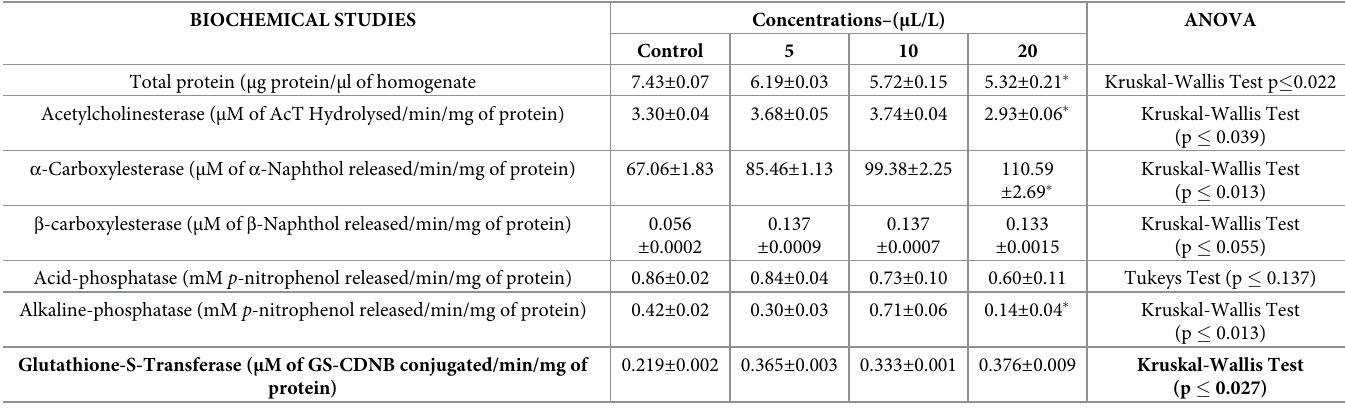
nature; they are easy to use and kill the pests of stored grains. Hence, in the present study, EO extracted from C . citrinus leaves was tested for its potential against the larvae and adult beetles of T . castaneum . GC-MS analysis of C . citrinus revealed ten different compounds, in which eucalyptol (40.44%) was the major constituent, followed by linalool, and α - Pinene. However, the same plant from Ethiopia contained 76.9% of eucalyptol and from Western Himalayas it contained only 9.8% eucalyptol [39, 40]. These data clearly indicate that the level and type of constituents in EO extracted from this plant varies depending on where the plant was collected, and most likely the climate and ecology of that region playing a role. These results are in accordance with Misharina [41], Souza and Vendramim [42] and Isikber et al. [43] who indicated that the